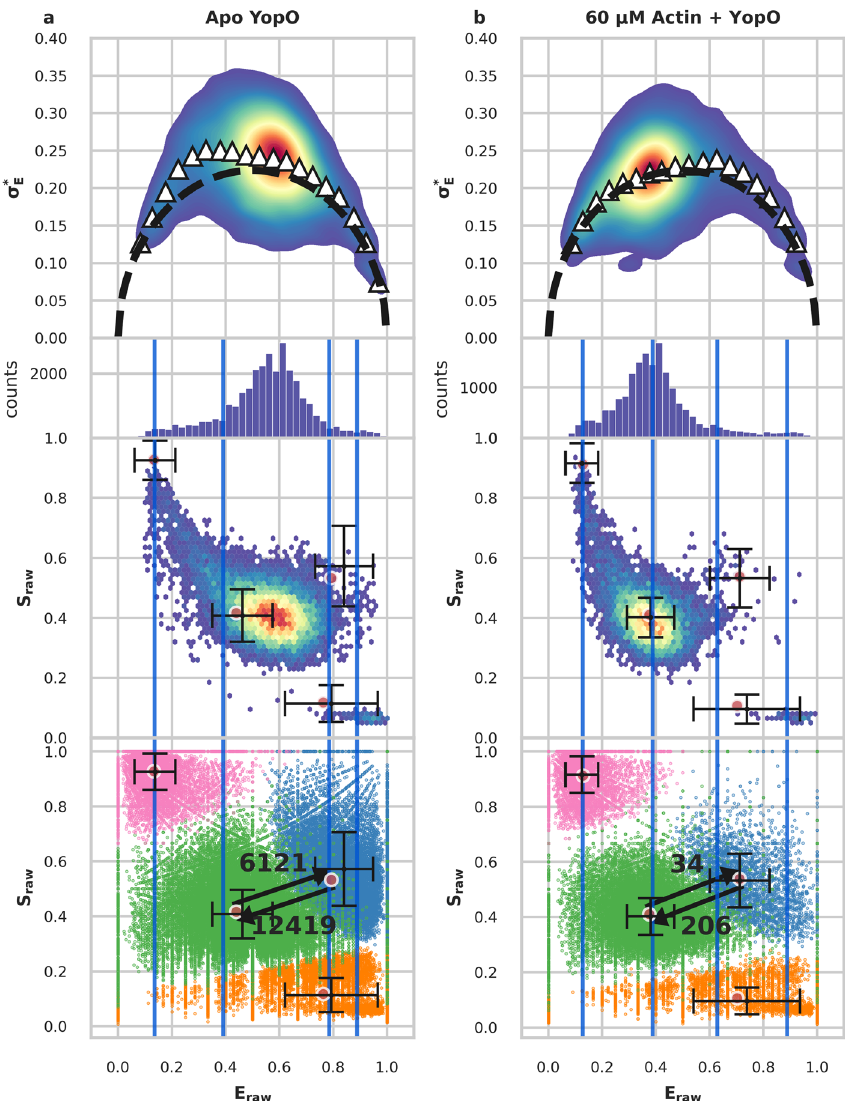
Fig. 4 Results for YopO. a , b Top row: BVA analysis. Upper middle row: E raw histogram of bursts, lower middle row: E-S plot of bursts. Red dots indicate mpH 2 MM states. Bottom row: Dwell based E-S plots as in Fig. 2, with transition rates (in units of s − 1 ) between selected states indicated by arrows added. Vertical bars indicate the E raw values of the states for the BIC'-based spH Eraw model. a apo YopO exhibiting sub-millisecond dynamics. b YopO with 60 μ M actin exhibiting slower within-burst dynamics, and a shift toward the lower FRET conformation. Error bars (s.d.) for a n = 40,723, 89,613, 108,641, and 89,613 dwells for dark donor, dark acceptor, low FRET, and high FRET states respectively, for b n = 11,518, 9279, 31,100, and 3105 dwells for dark donor, dark acceptor, low FRET, and high FRET states,